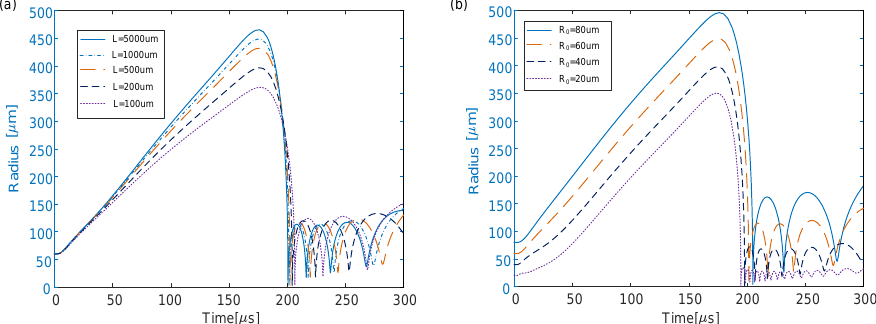
Figure 3. Influence of distance and initial bubble radius on bubble evolution. ( a ) Influence of distance on bubble evolution. ( b ) Influence of initial bubble radius on bubble evolution.